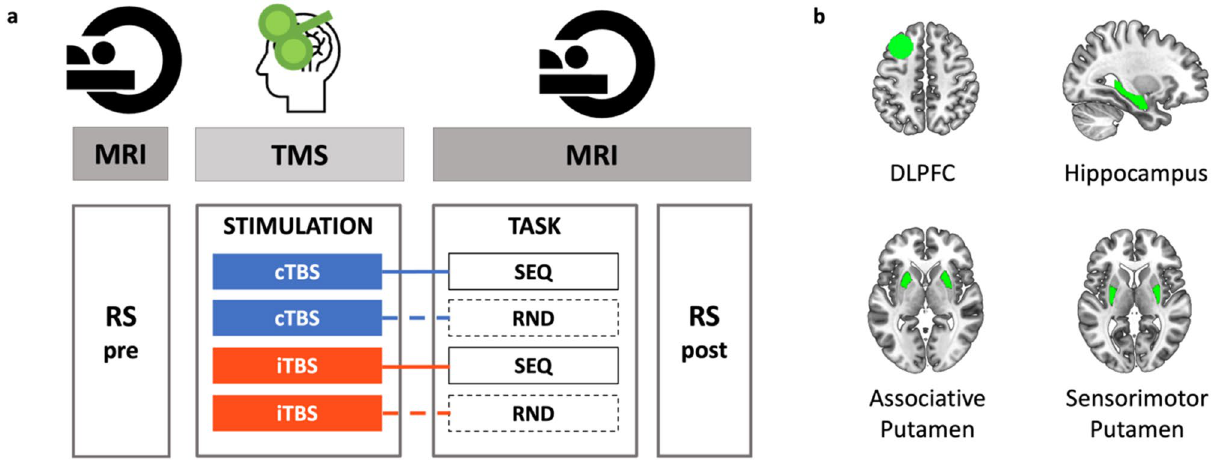
Figure 1. Experimental design and regions of interest. ( a ) In each experimental session, participants first underwent pre-TMS whole-brain resting-state (RS) fMRI scans, followed by T1-neuronavigated intermittent or continuous theta-burst stimulation (iTBS [190 s] or cTBS [40 s]) applied to an individually-defined DLPFC target outside the scanner (mean time between start RS pre and start TBS: 54.49 min, range 43-77 min). Directly following stimulation, participants were placed in the MR scanner where they were trained on the motor task (sequential [SEQ, indicated by solid lines] or random [RND, indicated by dashed lines] versions of the serial reaction time task) while BOLD images were acquired (mean delay between start TBS and start task: 15.71 min, range 12-22 min; mean duration of the task training: 11.5 min, range 9.33-13.43 min). After task completion, post-stimulation/task RS data were acquired (mean time between start TBS and start RS post: 32.49 min, range 28-37 min). The order of the four experimental conditions in this within-subject design [cTBS/SEQ (cSEQ), cTBS/RND (cRND), iTBS/SEQ (iSEQ), iTBS/RND (iRND)] was counterbalanced across participants. ( b ) Regions of interest (ROIs) for multivoxel correlation structure analyses. The dorsolateral prefrontal cortex (DLPFC) ROI consisted of a 10-mm-radius sphere centered around the individual TMS targets. The deeper ROIs were delineated using FSL FIRST and the Oxford-GSK-Imanova Striatal Connectivity Atlas. TMS - transcranial magnetic